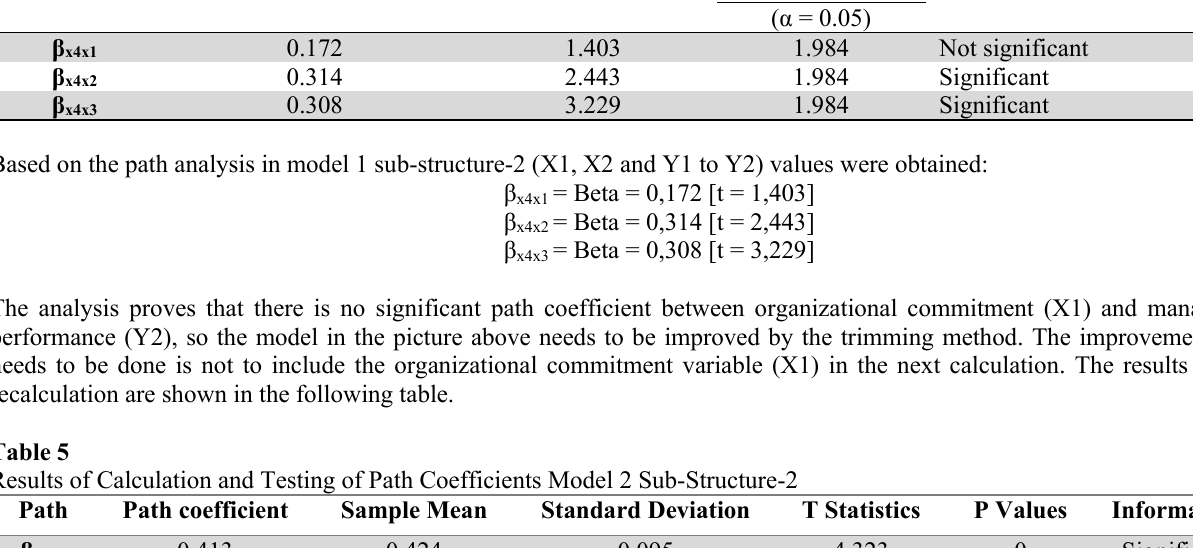
Results of Calculation and Testing of the Path Coefficient Model 1 Sub-Structure-2 Path